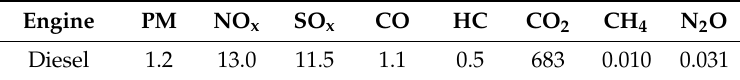
Table 4. Emission factors for oceangoing ships (g/kWh) [15].